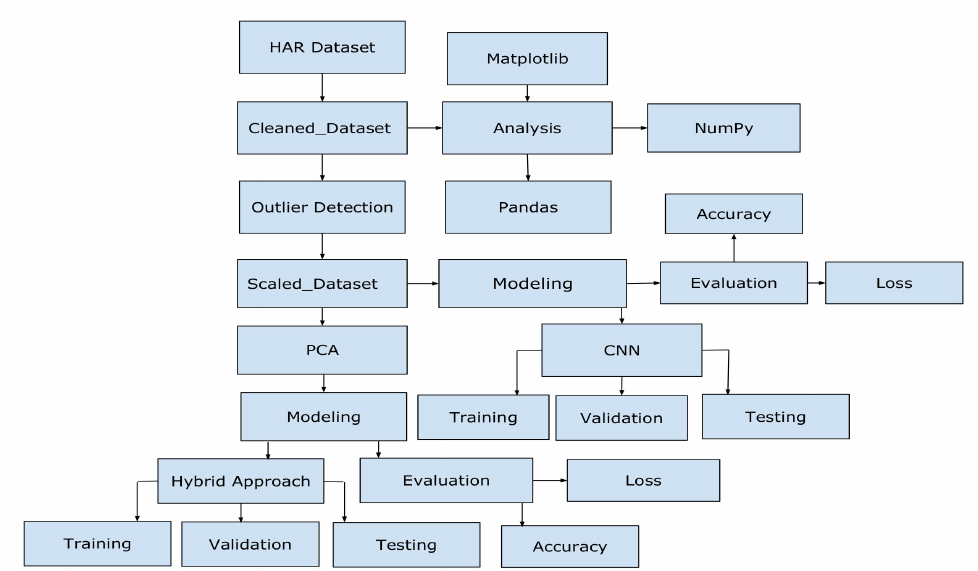
Figure 1. Proposed Methodology for human activity recognition